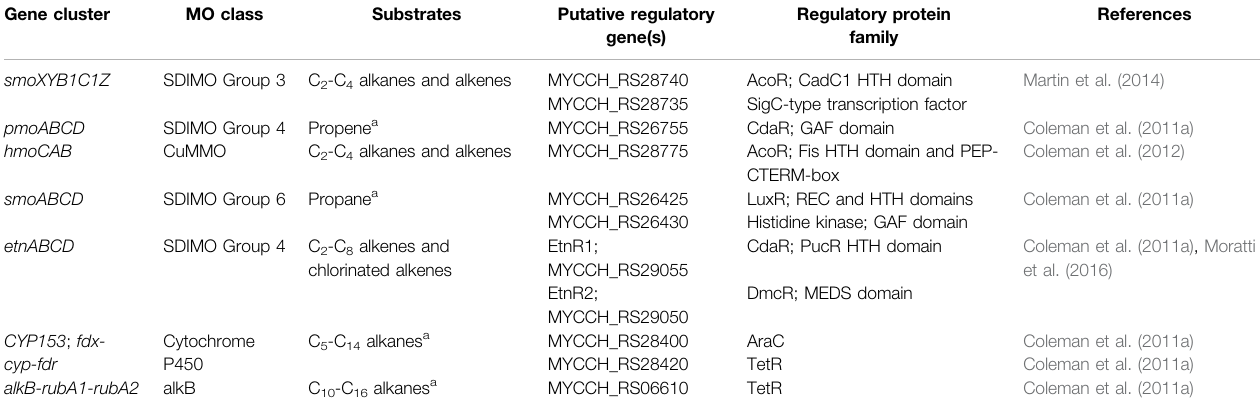
TABLE 5 | Putative regulatory genes associated with monooxygenase clusters in Mycobacterium chubuense NBB4.